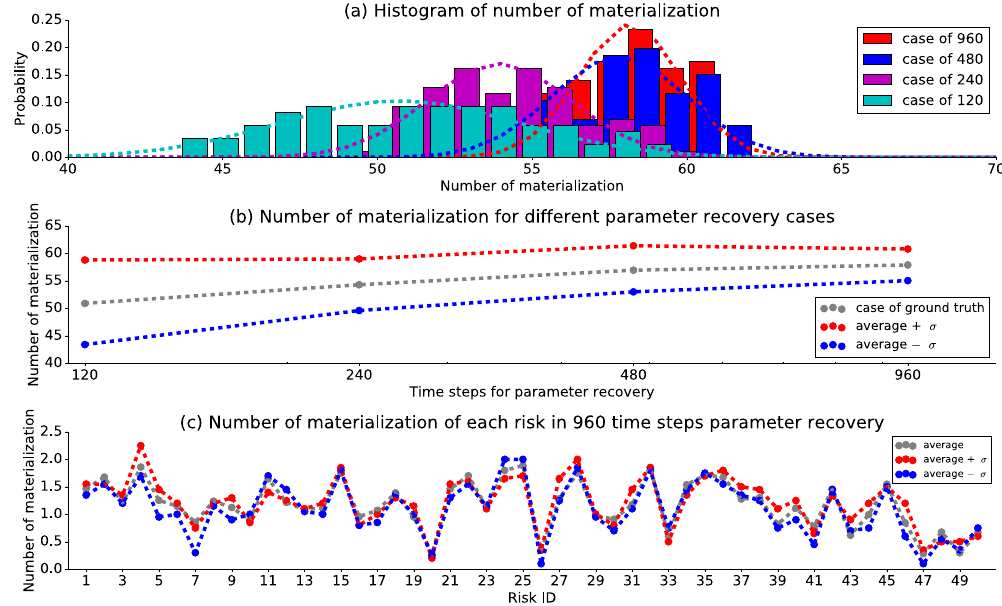
Figure 6. Performance comparison of recovered parameters in the global risk network. There are 125 cases of estimated parameters. 4 different periods of time steps (120, 240, 480 and 960) are used to estimate parameters and simulate future behaviors. For each set of estimated parameter, we finish 20 realizations and average the number of materialization during the simulation. ± σ boundary is determined by removing 39 sets of estimated parameters with worst performance from ground truth case. ( a ) Histogram of number of materialization. ( b ) shows the boundary of ± σ performance for number of materialization in each period. ( c ) shows the number of materialization for each risk in the case of 960 time